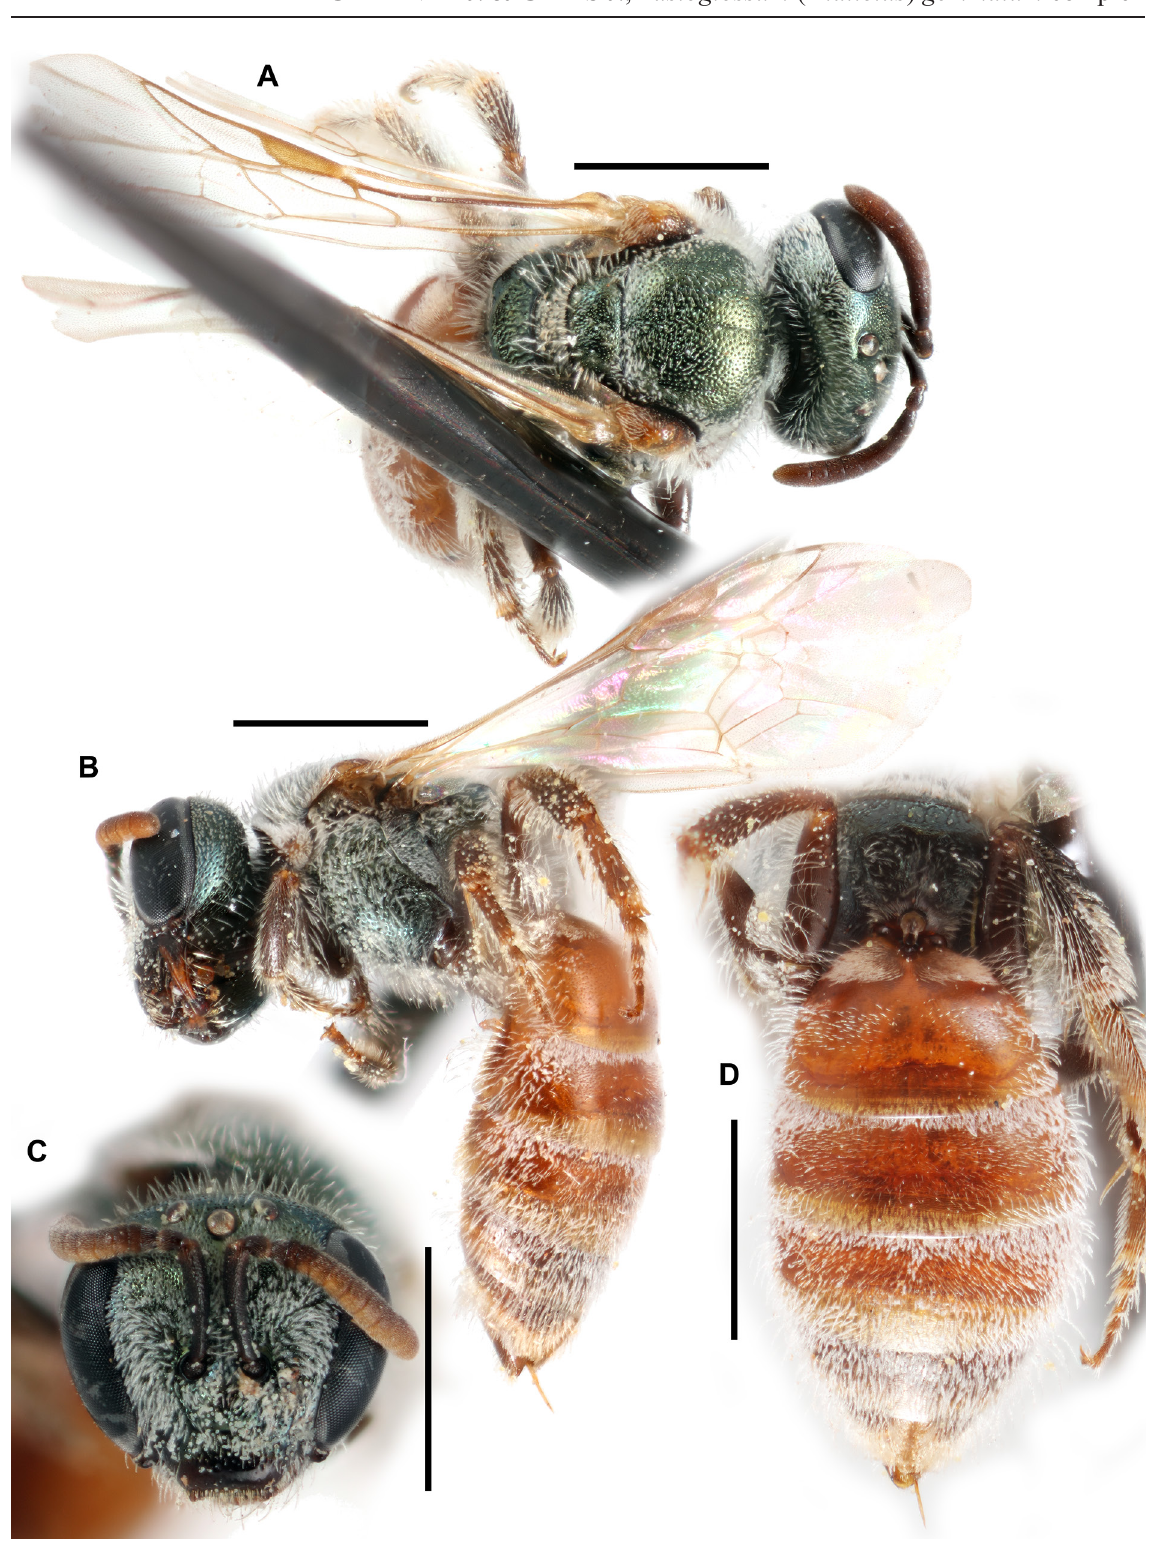
Fig. 27. Lasioglossum ( D .) gloriosum sp. nov., ♀, holotype (CUIC). A . Dorsal habitus. B . Lateral habitus. C . Face. D . Metasoma and propodeum. Scale bars = 1